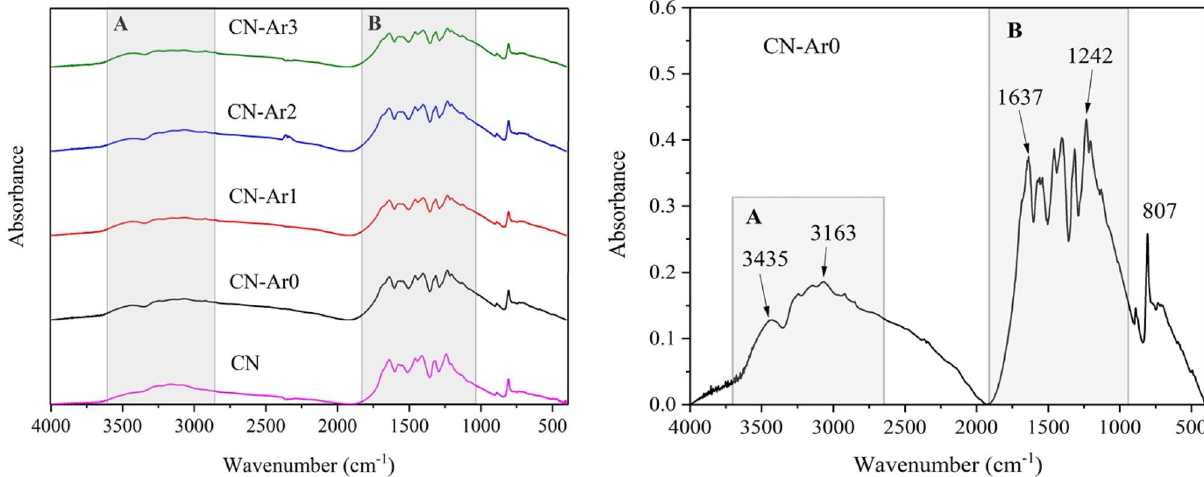
Figure 5. FTIR spectra of CN and CN-Ar materials (left) and spectrum of CN-Ar0 (right).